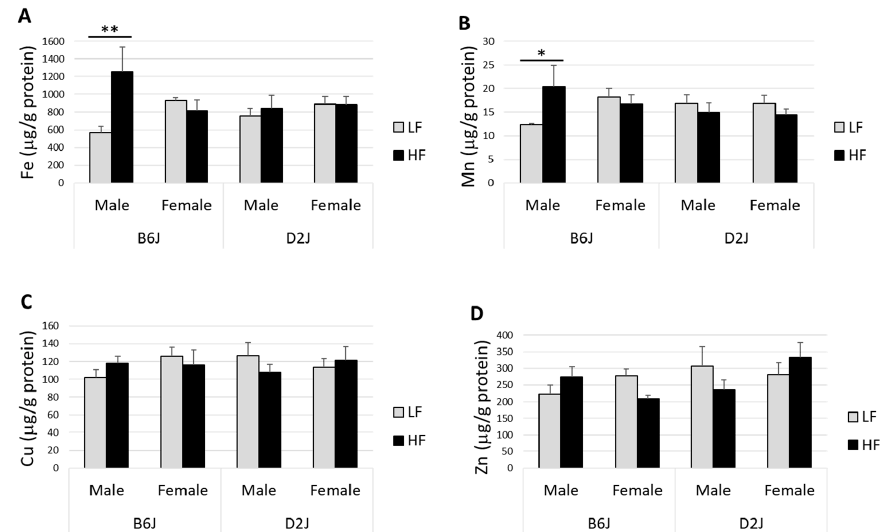
Figure 2. Impact of diet-induced obesity (DIO) on olfactory bulb trace elements. The effects of diet, sex, and strain on olfactory bulb iron (Fe) ( A ), manganese (Mn) ( B ), copper (Cu) ( C ), and zinc (Zn) ( D ) in male and female C57BL / 6J (B6J) and DBA / 2J (D2J) mice. Male B6J mice fed a high-fat diet have significantly increased levels of both Fe and Mn. Data are represented as mean ± SEM. * p < 0.05, ** p < 0.01. LF = low fat, HF = high